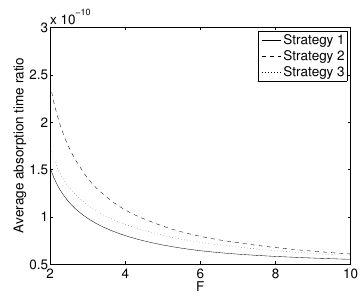
Figure 14: Ratio between values of τ with and without attacker, F ∈ [2 ,